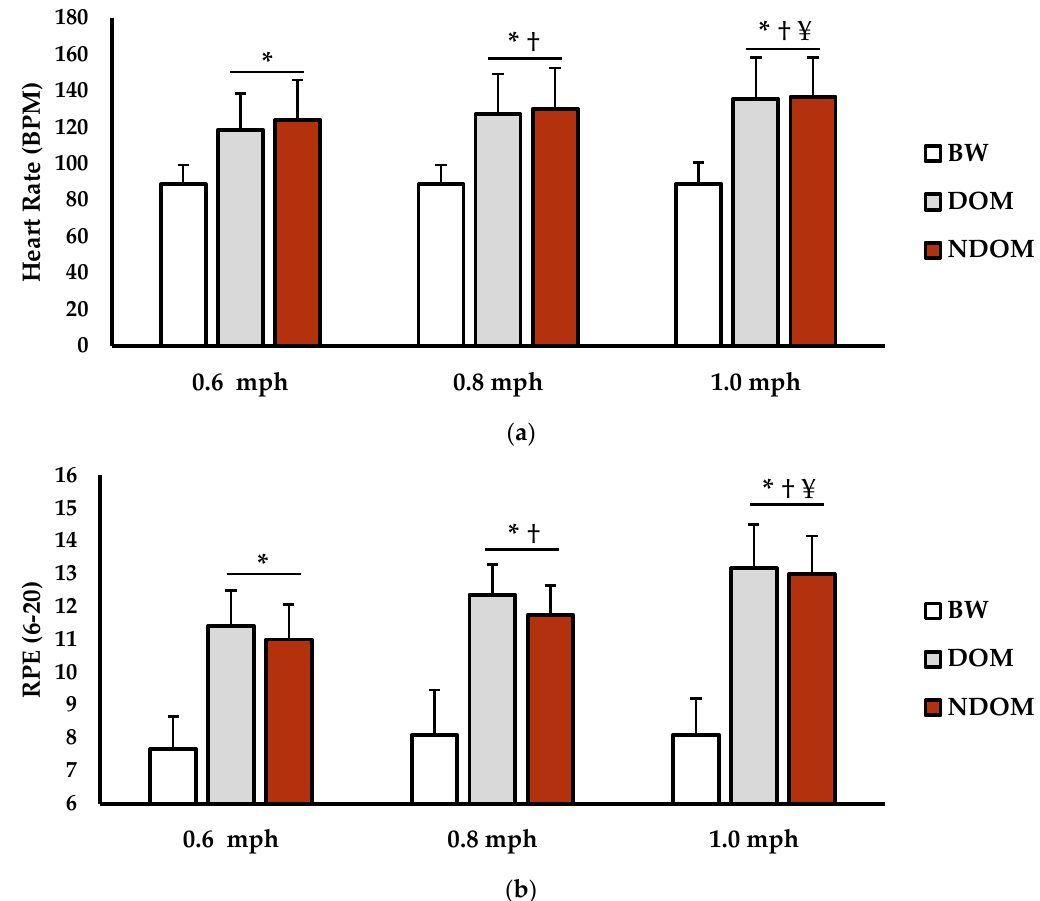
Figure 3. ( a ) Heart rate (bpm) for the 0.6, 0.8, and 1.0 mph speed phases between the bipedal walking (BW; white bars), dominant (DOM; light grey bars), and nondominant (NDOM; red bars) conditions. ( b ) Rate of perceived exertion (RPE; 6–20 scale) for the 0.6, 0.8, and 1.0 mph speed phases between the bipedal walking (BW; white bars), dominant (DOM; light grey bars), and nondominant (NDOM; red bars) conditions. The data are presented as mean ± SD. * indicates significantly different from BW ( p < 0.05). † indicates significantly different from 0.6 mph ( p < 0.05). ¥ indicates significantly different from 0.8 mph ( p <